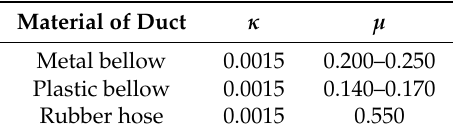
Table 1. Suggested values of κ and µ in Chinese code.